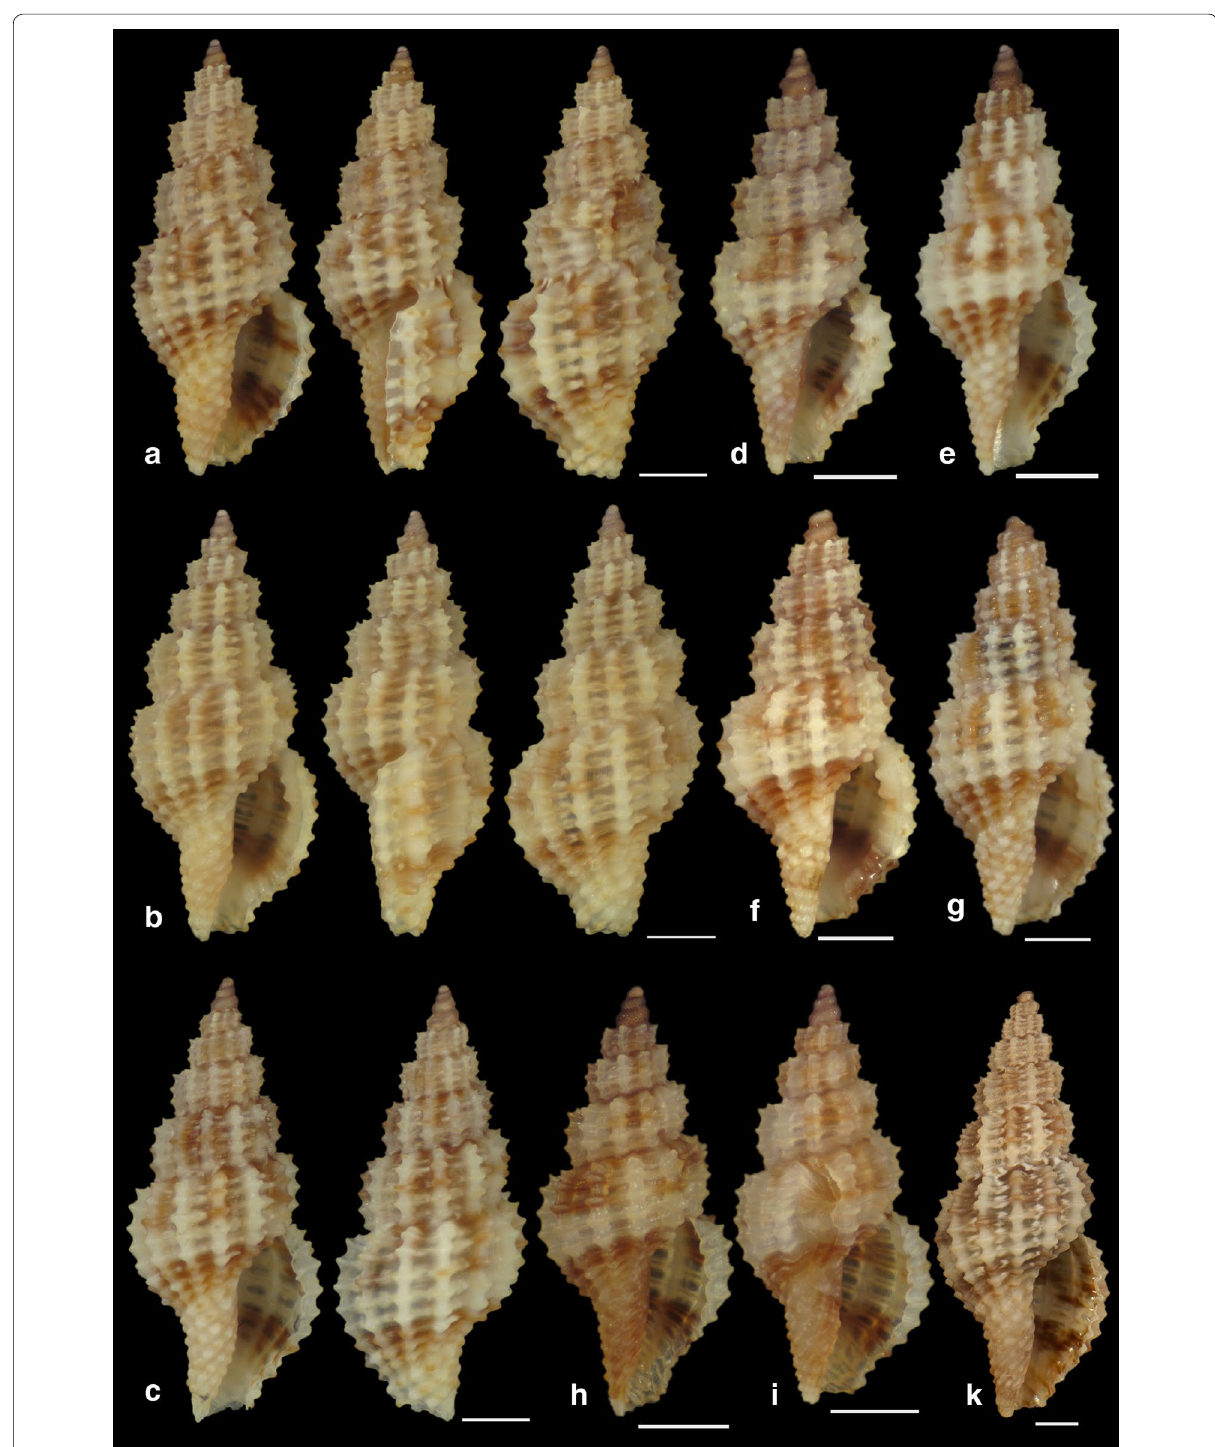
Fig. 20 a – j Raphitoma melitis sp. n., a Paratype 3 (6.50 mm), b Paratype 4 (6.20 mm), c Paratype 5 (6.25 mm), d – j Paratypes 6–12, respectively.